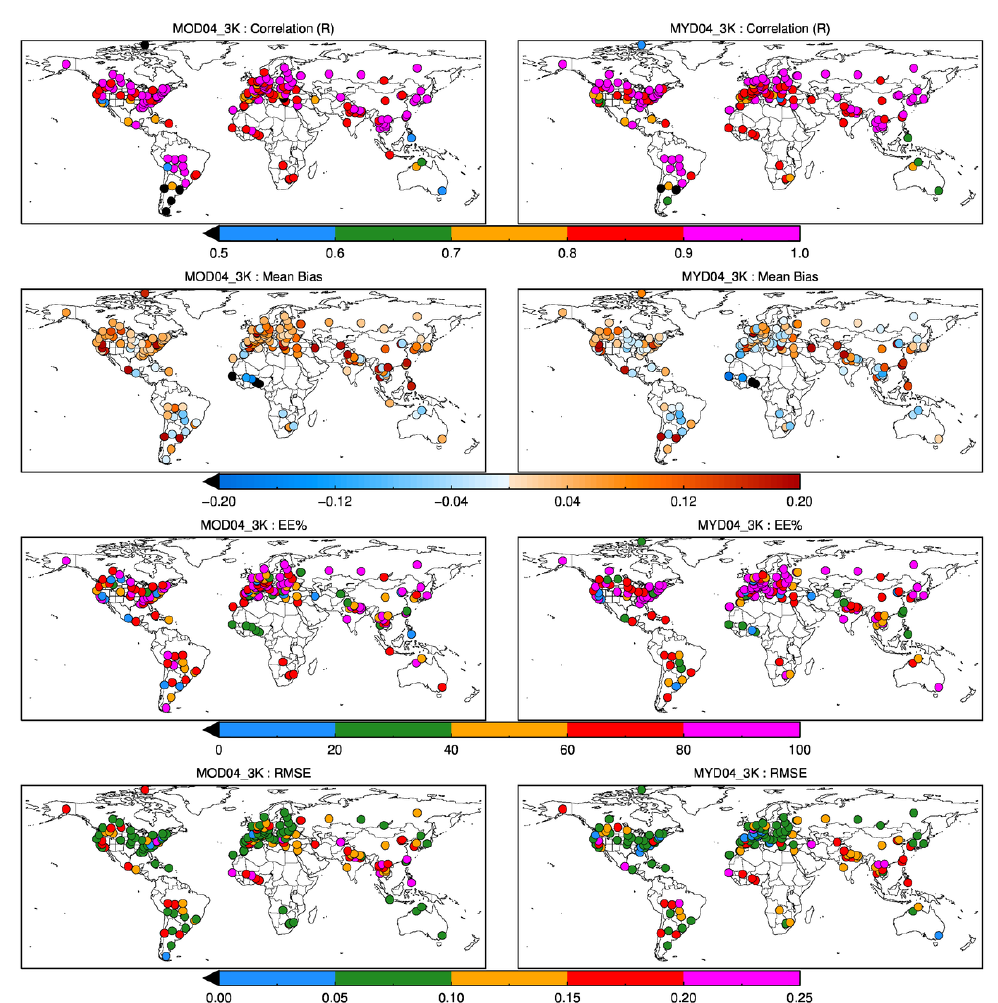
Figure 4. Statistics calculated from the collocation database at each AERONET station, individually, for Terra on the left and Aqua on the right. Shown are values for correlation coefficient ( R ), mean bias, percentage within expected error (EE%), and RMSE. Only stations with at least 100 collocations are plotted, which may differ between the two satellites, and only collocations with MODIS retrievals of QAF = 3 are